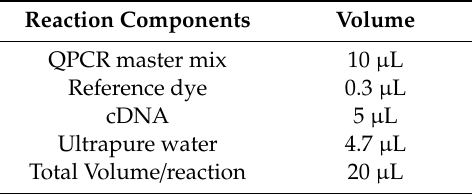
Table 2. Real-Time PCR reaction